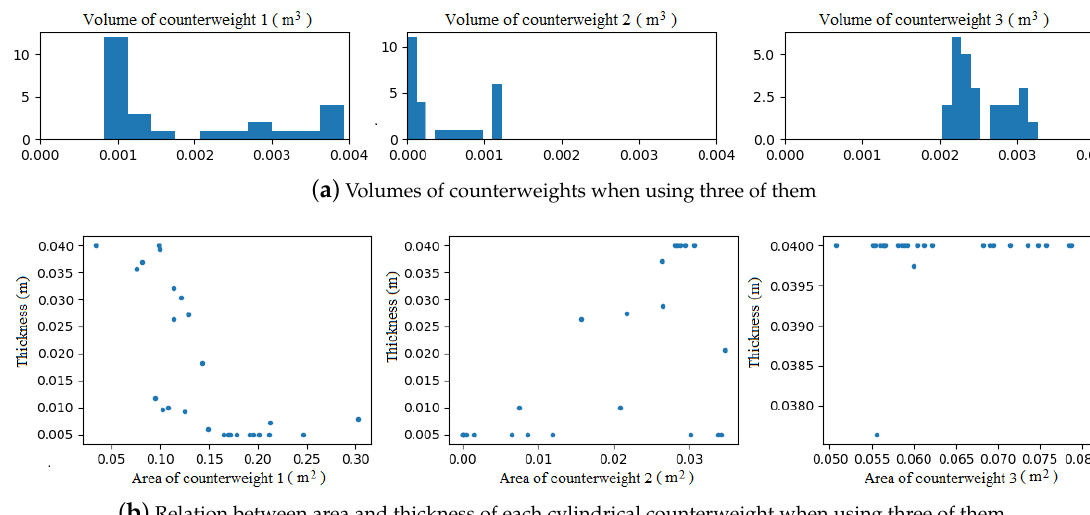
Figure 7. Parameters used to analyze the dimension of each counterweight when using three of